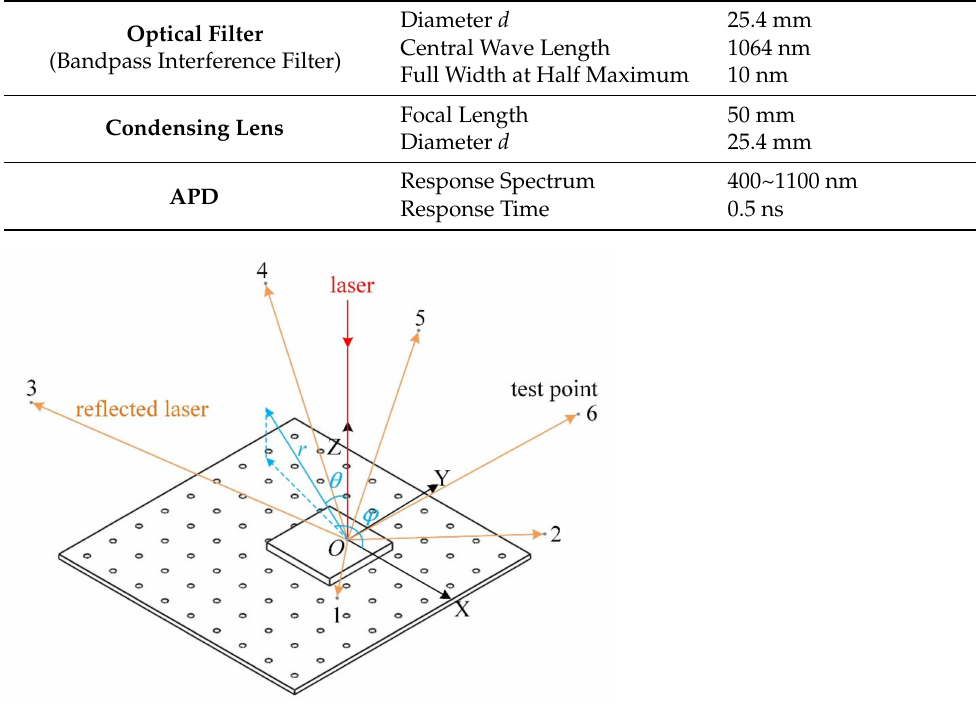
Figure 5. Locations of radiation intensity sensors. Table 3. Coordinates of radiation intensity